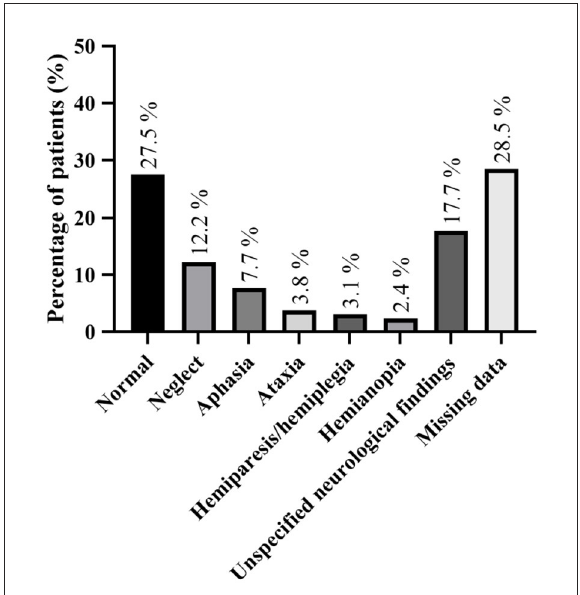
FIGURE2 Detailed neurological examination findings; more than one neurological defect could be found in some patient.